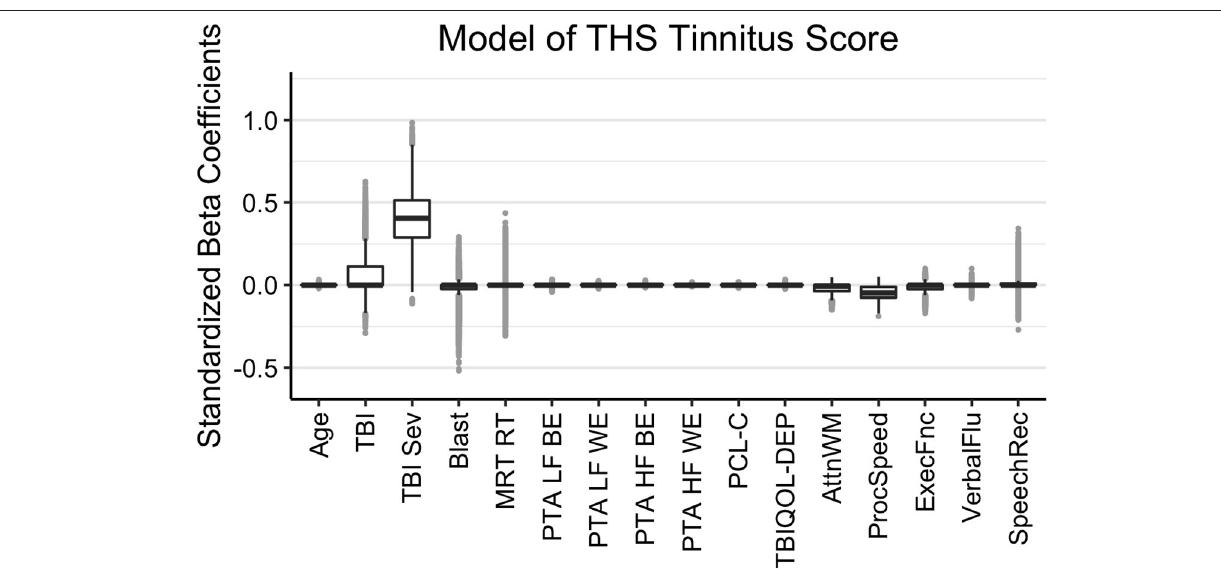
FIGURE 3 | Regression coefficients for self-reported difficulties with tinnitus (THS Tinnitus). Median intercept (mu) = 0.50 (Q1 = 0.14, Q3 =